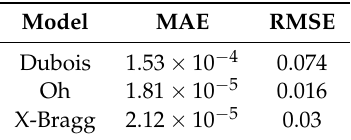
Table 1. Calculation error of m v with CPU and GPU